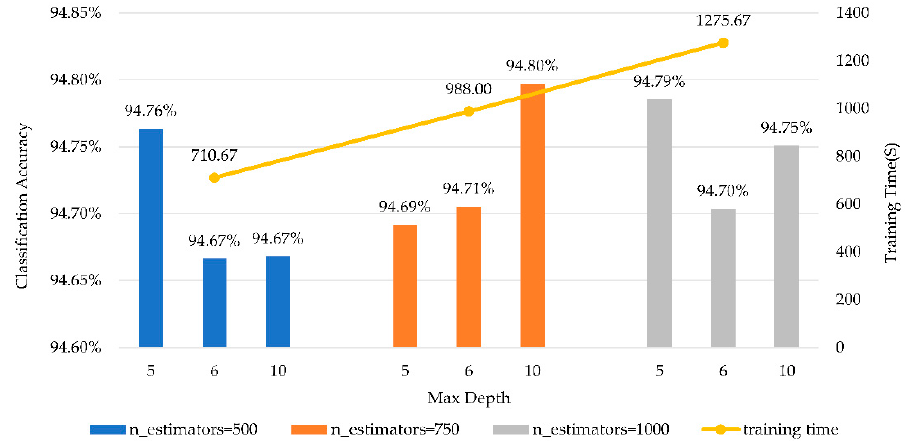
Figure 14. Test set classification accuracy of ExtraTreesClassifier with different sizes.